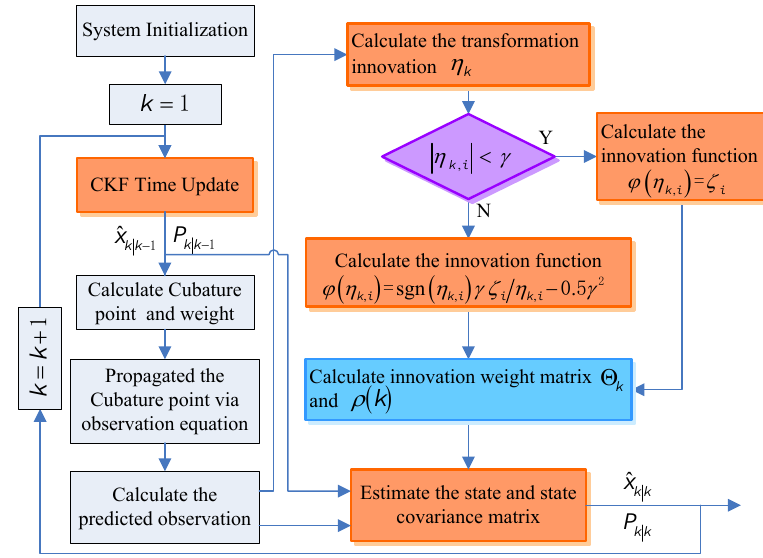
Figure 3. The flow chart of the RHCKF method.